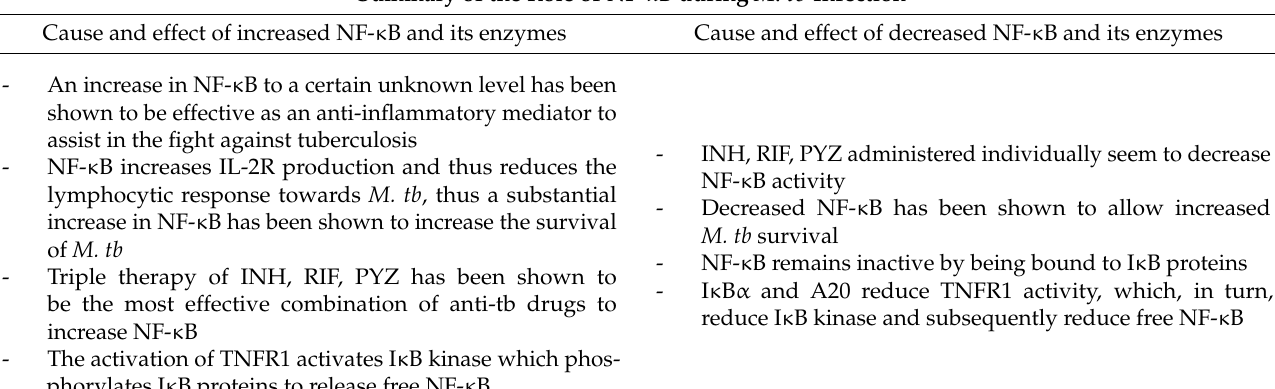
Figure 1. Signaling pathways revolving around NF- κ B and the effect of M. tb . ( A ) TNF- α binds with TNFR1 to activate I κ B kinase leading to increased free NF- κ B signaling to produce various pro-inflammatory cytokines such as IL-1, IL-6, IL-12, TNF- α , and activated macrophages. ( B ) The additional products of NF- κ B containing I κ B α and A20 result in the inhibition of TNFRI, an activator of IKK. The inhibition of TNFR1 and the subsequent inhibition of IKK leads to a decrease in NF- κ B. ( C ) The Rv0927c gene activated during an M. tb infection reduces NF- κ B signaling and, in turn, increases M. tb growth and survival as a result. Table 1. A summary of methods that increase and decrease NF- κ B activity. As well some of the mediators of NF- κ B’s activity. In addition, some of the effects of NF- κ B towards M. tb infection. Summary of the Role of NF- κ B during M. tb